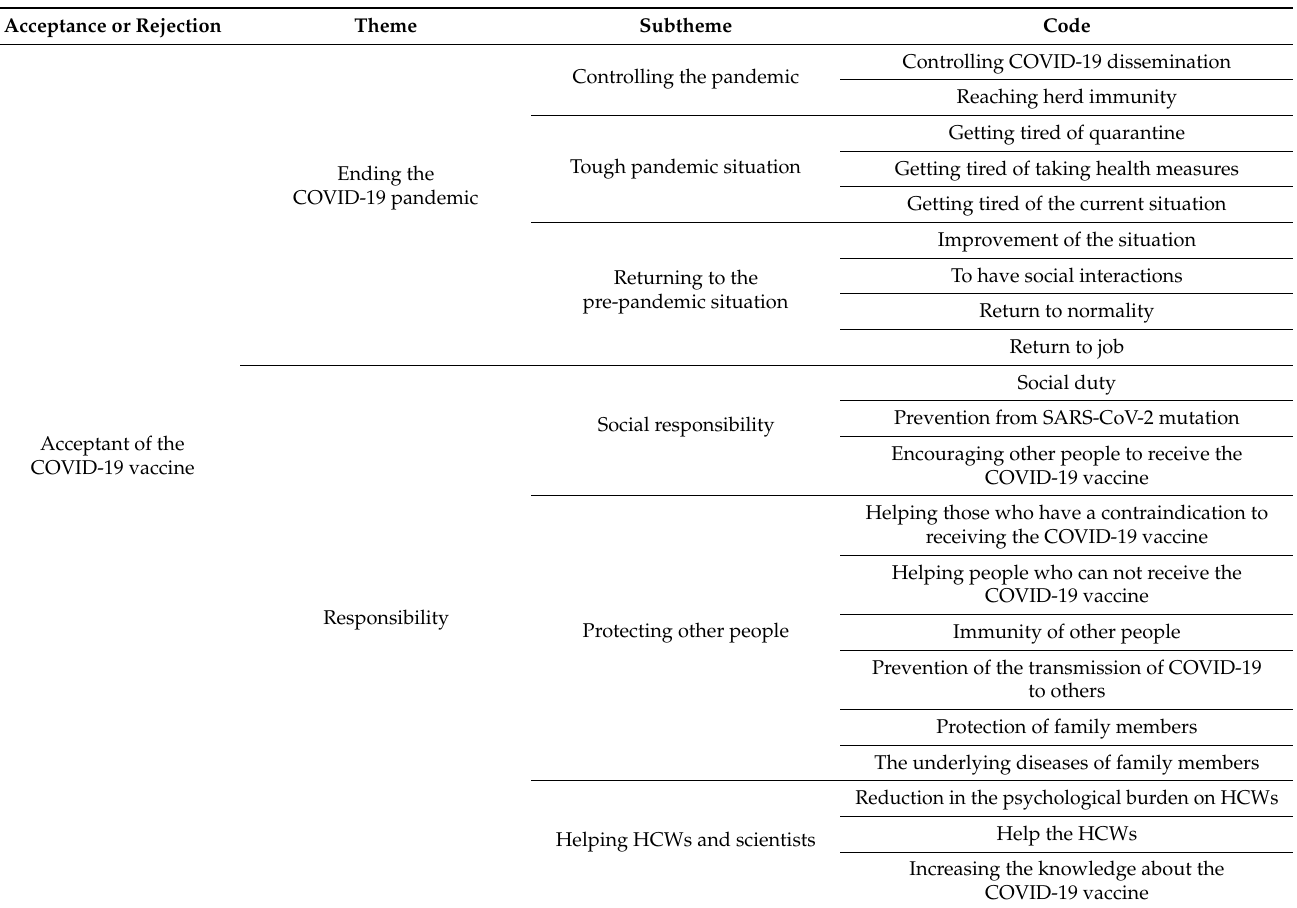
Table 5. Thematic analysis of participants’ reasons to accept or reject the COVID-19